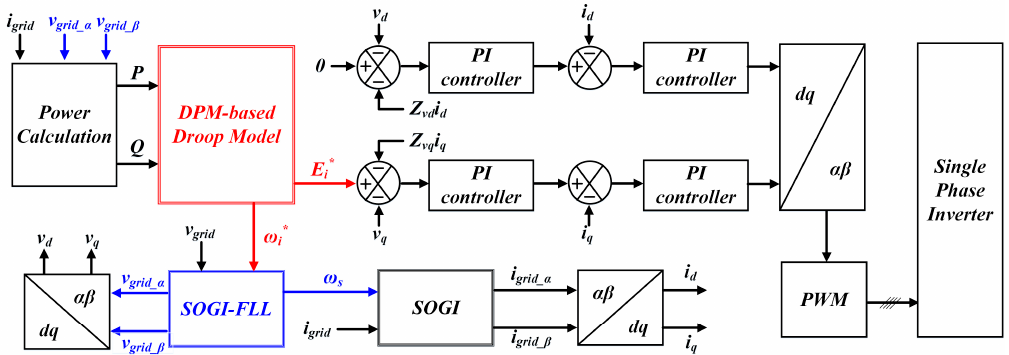
Figure 9. Control block diagram of droop-controlled parallel-inverter using the proposed control strategy.